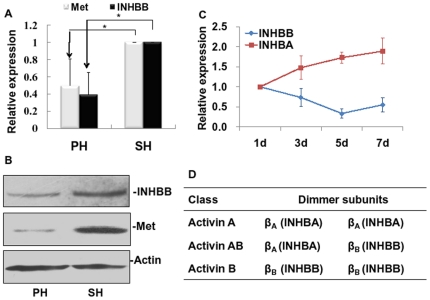
Expression of INHBB and Met in regenerating livers.(A) mRNA expression of INHBB and Met in regenerating liver at 5 d after resection by qRT-PCR. (B) Protein expression of INHBB and Met in regenerating liver at 5 d by westernblot analysis. Actin was used as sample control. (C) Expressive patterns of INHBB and INHBA mRNA in the regenerating liver after PHx by qRT-PCR. (D) The activin protein complexes are composed of inhibin beta A (INHBA) and inhibin beta B (INHBB) subunits.